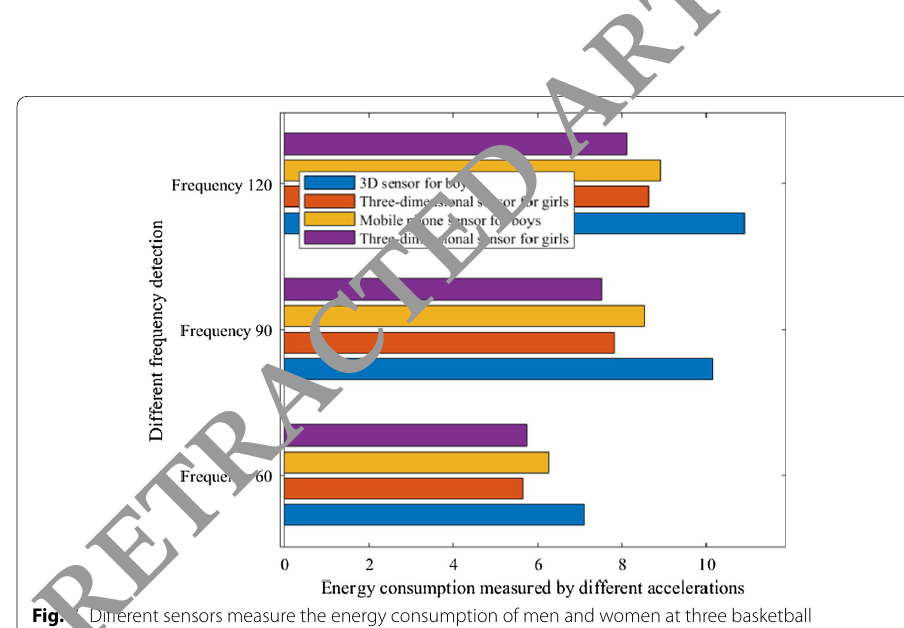
Fig. 5 Different sensors measure the energy consumption of men and women at three basketball frequencies